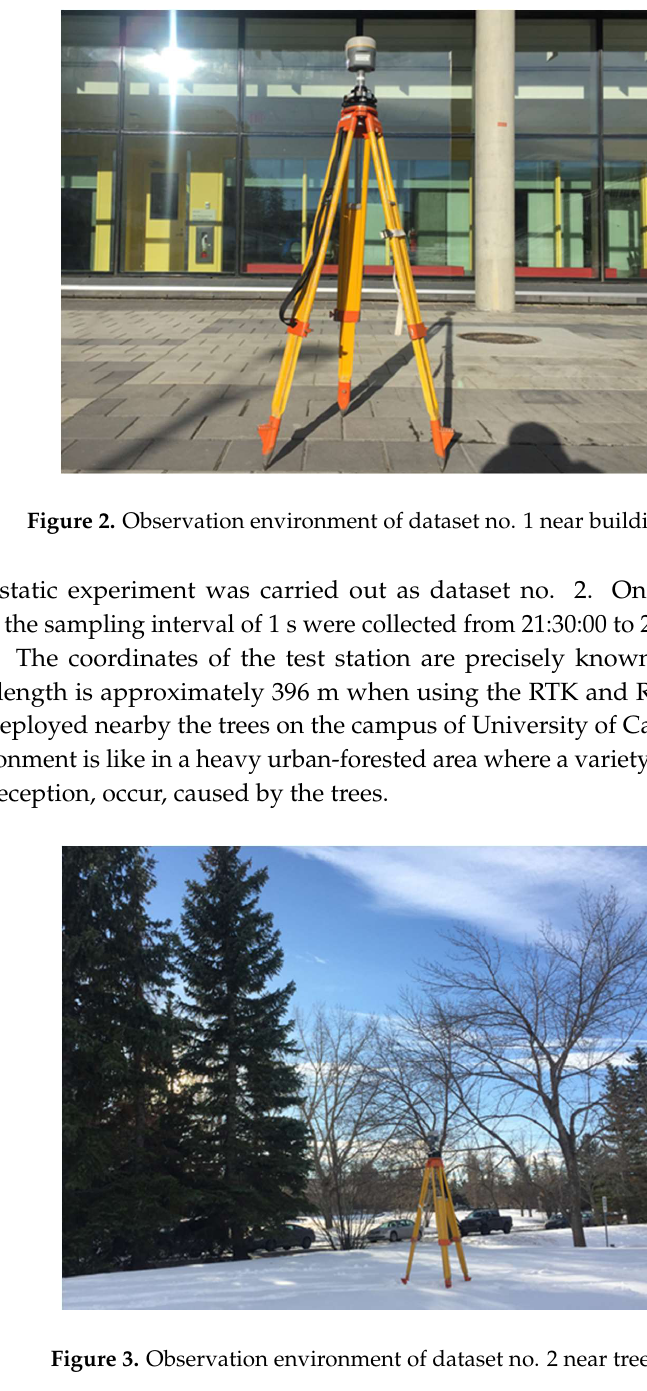
Figure 3. Observation environment of dataset no. 2 near trees.